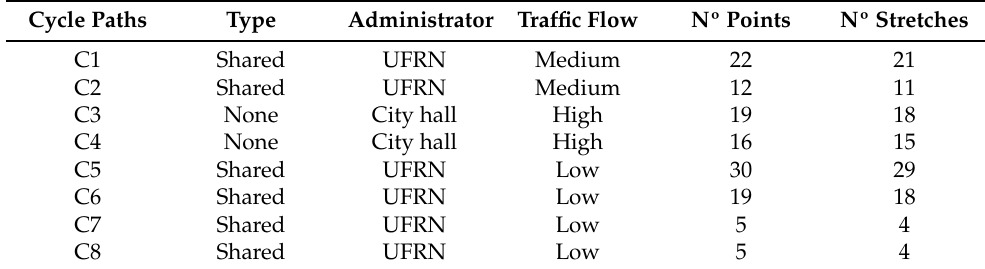
Figure 12. Cycle paths on the UFRN central campus, which were mathematically modeled according to the BikePathGen implementation. Table 5. Characteristics of the UFRN central campus cycle